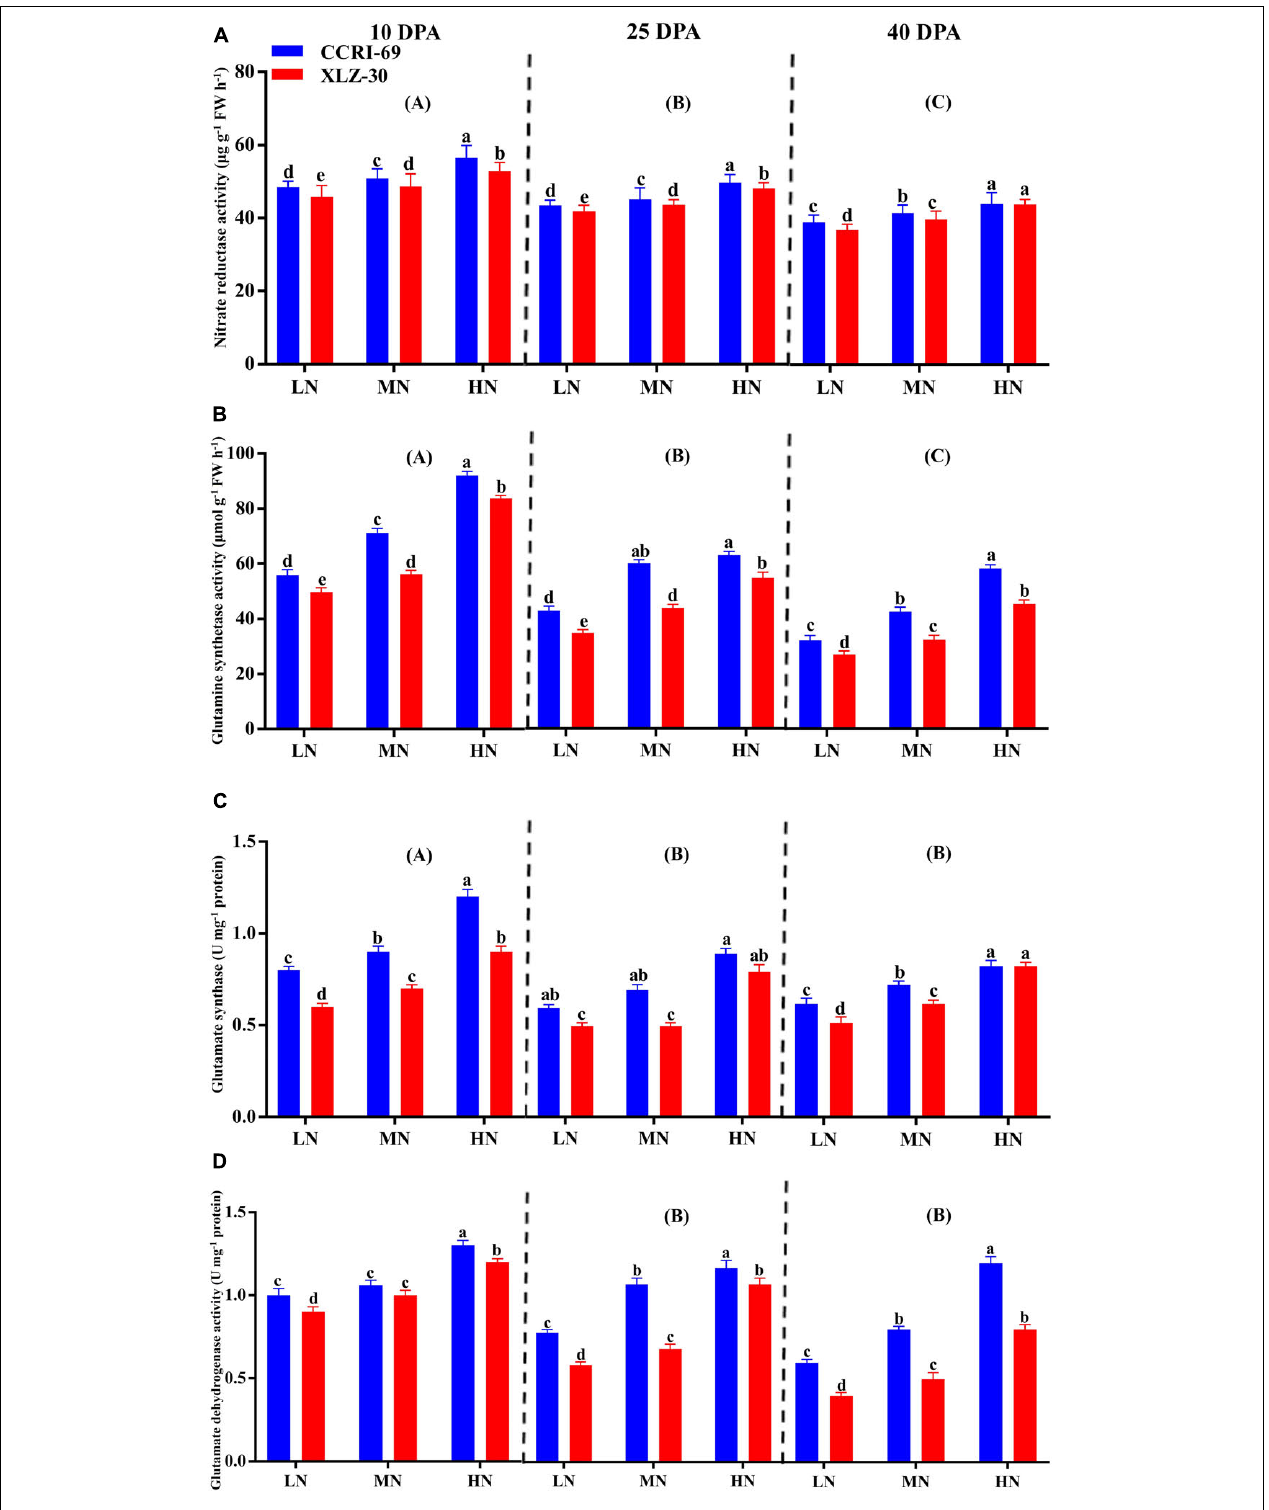
FIGURE 3 | (A–D) Nitrate reductase activity ( µ g g − 1 FW h − 1 ), glutamine synthetase activity ( µ mol g − 1 FW h − 1 ), glutamate synthase (U mg − 1 protein), and glutamate dehydrogenase activity (U mg − 1 protein) in cotton subtending leaves of CCRI-69 and XLZ-30 in response to low (LN; 0.25 mM), moderate (MN; 2.5 mM), and high (HN; 5 mM) N levels at 10, 25, and 40 days post-anthesis (DPA). Error bars with different small letters show a significant difference between genotypes under different N levels and capital letters in the brackets show significant differences among growth stages (10, 25, and 40 DPA) at p < 0.05.